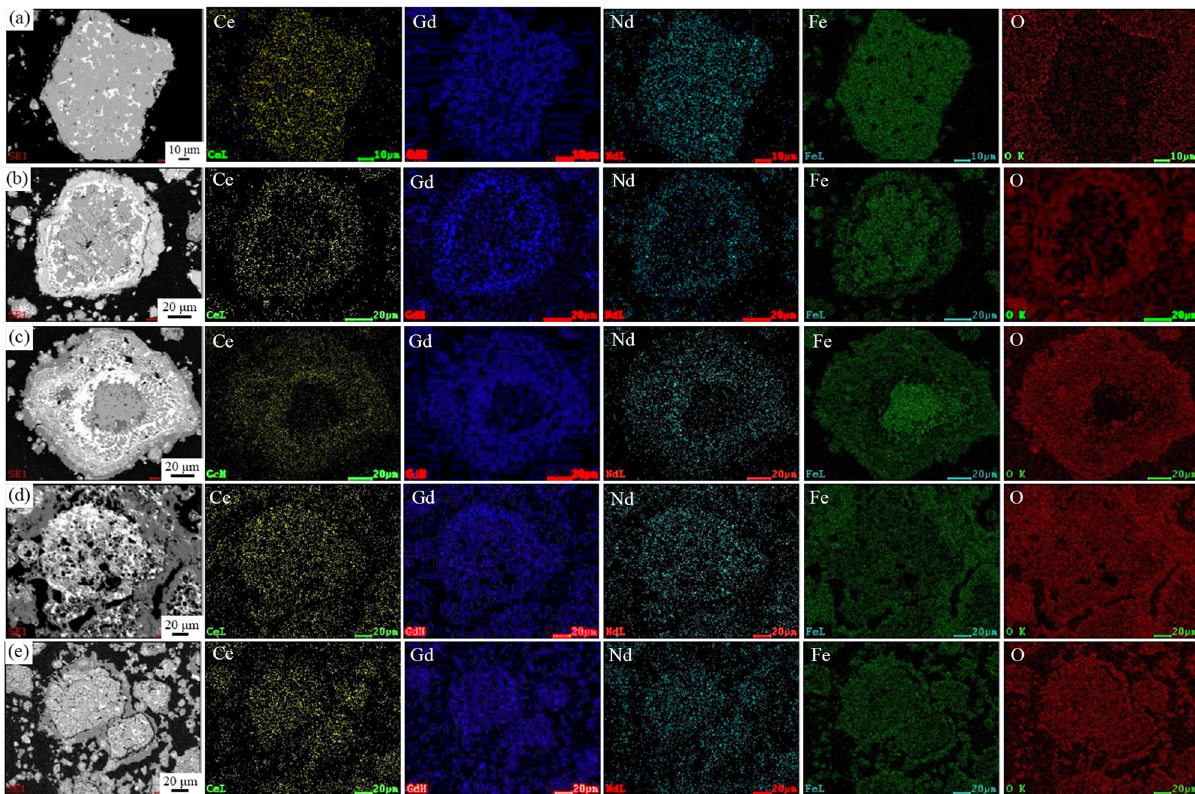
Figure 8: The mapping distribution of elements for the Ce – Fe – B magnet scrap powder oxidized at 800°C with di ff erent roasting cycles. ( a ) Unroasted Ce – Fe – B scrap powder; ( b ) fi rst cycle of roasting; ( c ) second cycle of roasting; ( d ) third cycle of roasting; ( e ) fourth cycle of